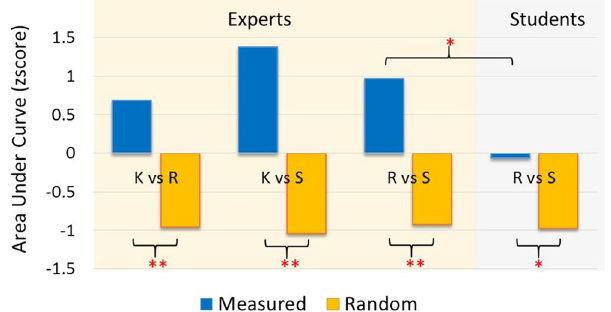
Figure 8. Bars plot related to the zscore-normalized Measured AUC (blue bars) distributions and the Random AUC (red bars) distributions, achieved by the ATCO Experts (left side) and Students (right side), referred to the discrimination accuracy between the three couples of conditions (S vs R, S vs K, R vs K) for Experts, and S vs R for Students. The three cognitive control behaviours could be significantly discriminate for both the groups (p < 0.05). In addition, the results show how the S and R behaviours were significantly (p < 0.05) more discriminable for the Experts than for the Students (p < 0.05).